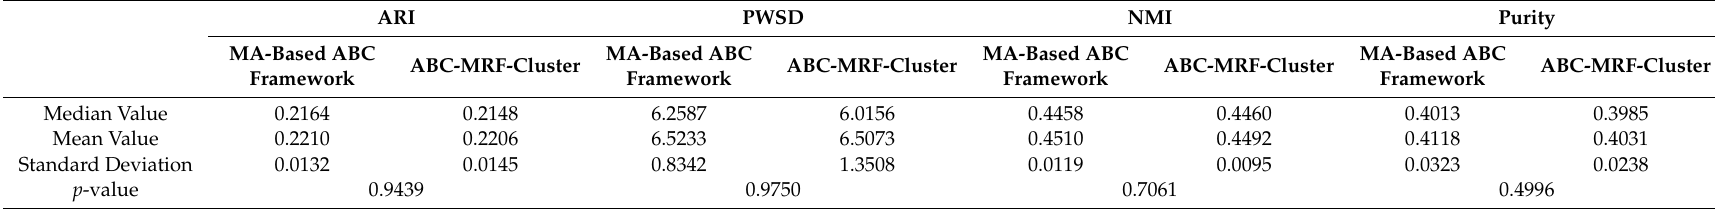
Table 6. Accuracy Statistics of the MA-based ABC Framework and the ABC-MRF-cluster in [5] for Dataset